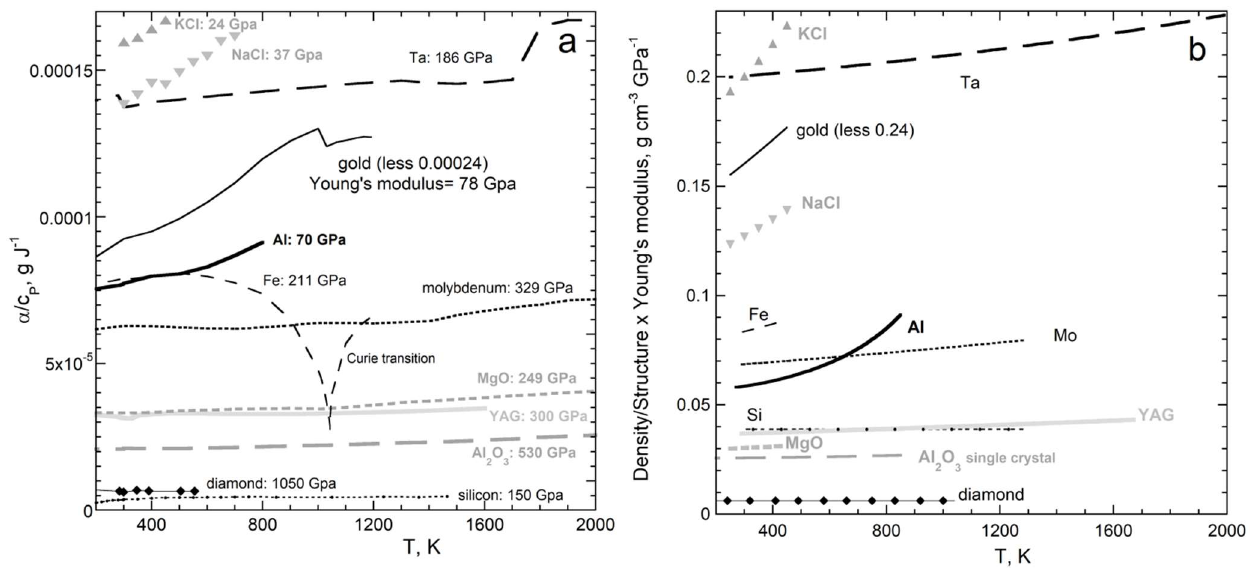
Figure 16. Evaluation of Equations (43) and (46) at high T for well-studied solids: ( a ) dependence of α/ c P on temperature. See Appendix A and Figures 13 and 14 for data sources. Jumps in Ta curve result from data-combining studies. The graph begins at 200 K as cryogenic data were previously shown to closely correspond [27–30]; ( b ) dependence of ρ /Ξ with the structural factor on T . Constant ambient ρ was used due to uncertainties in Young’s modulus. Measured data on Ξ from [85–91]. For Au, Fe, MgO, NaCl, and KCl, we used T derivatives near and above 298 K for B and G from [41] to compute dΞ/d T .